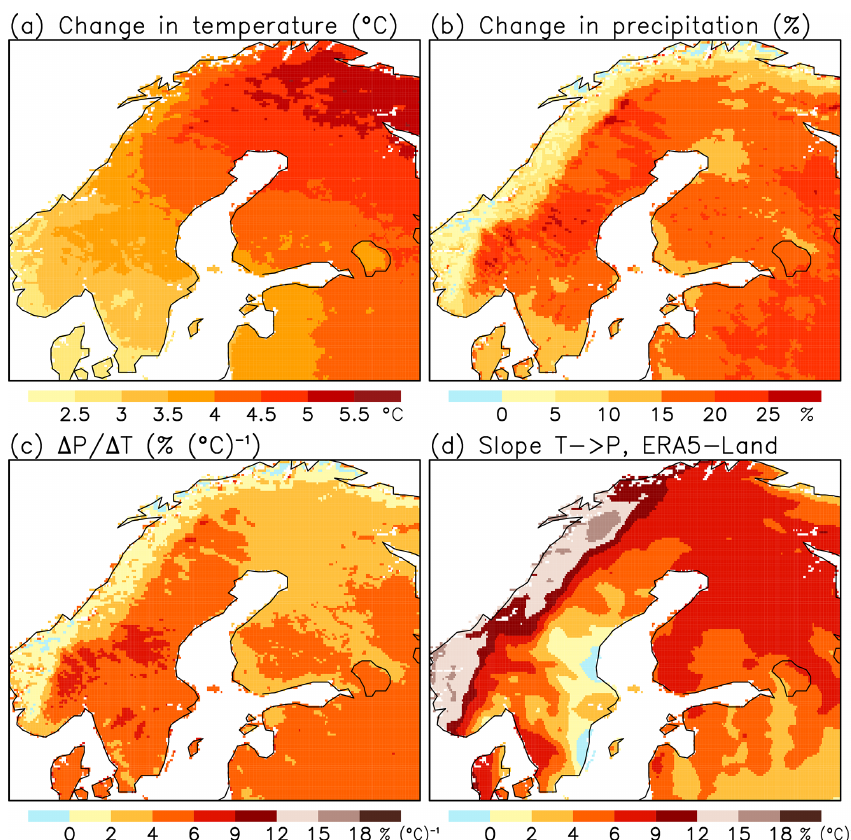
Figure 11. Multi-RCM mean changes in NDJFM mean of (a) temperature T and (b) precipitation P from 1981/82–2019/20 to 2059/60– 2097/98 and (c) the ratio of the precipitation change to the temperature change. (d) Slope b in least-square linear regression P (NDJFM) = a + bT (NDJFM) for interannual variability in 1981/82–2019/20, in